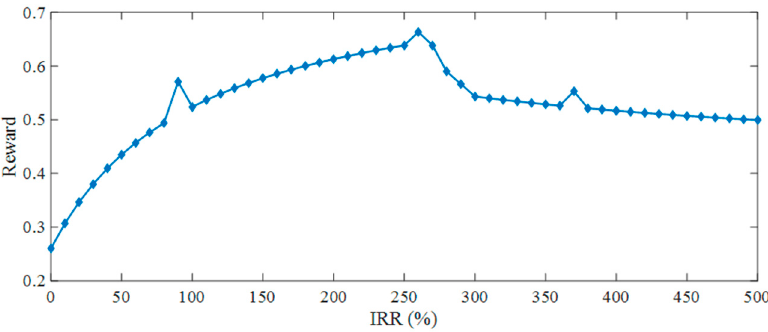
Figure 7. The pair of <reward-action> for IRR optimization.